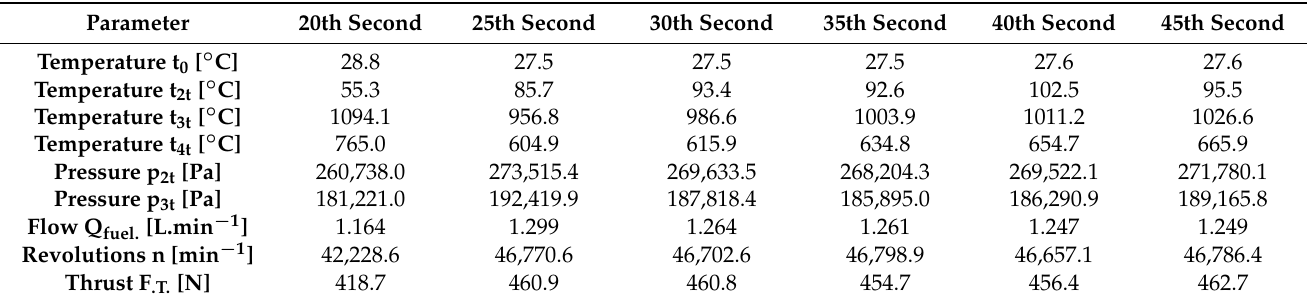
Figure 6. Graphic course of changes in SJE-20 parameters when using a mixture of 80% Jet A-1 aviation kerosene and 20% FAME biofuel. Table 8. Mixture of 80% Jet A-1 aviation kerosene and 20% FAME biofuel, 1st launch (40th second).